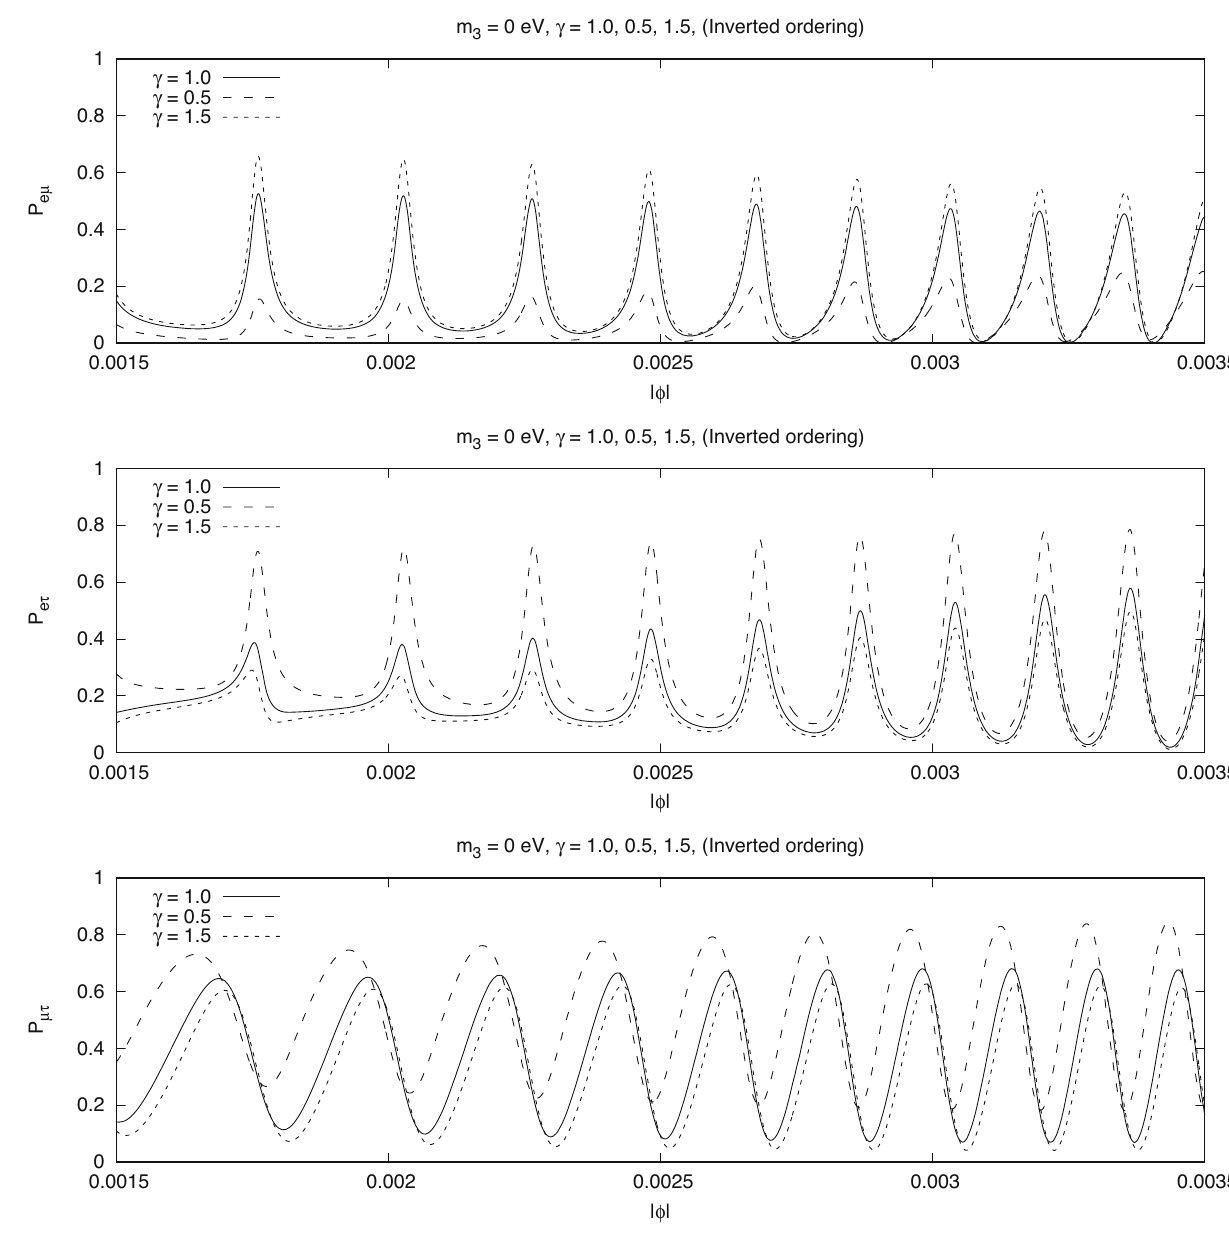
Fig. 8 Oscillation probability for the three flavor case in inverted hier- archy with m 3 = 0. Top panel: probability of ν e → ν μ conversion for γ = 1 . 0 (solid line), γ = 0 . 5 (dashed line), γ = 1 . 5 (dotted line). Mid panel: probability of ν e → ν τ conversion for γ = 1 . 0 (solid line), γ = 0 . 5 (dashed line), γ = 1 . 5 (dotted line). Bottom panel: probability